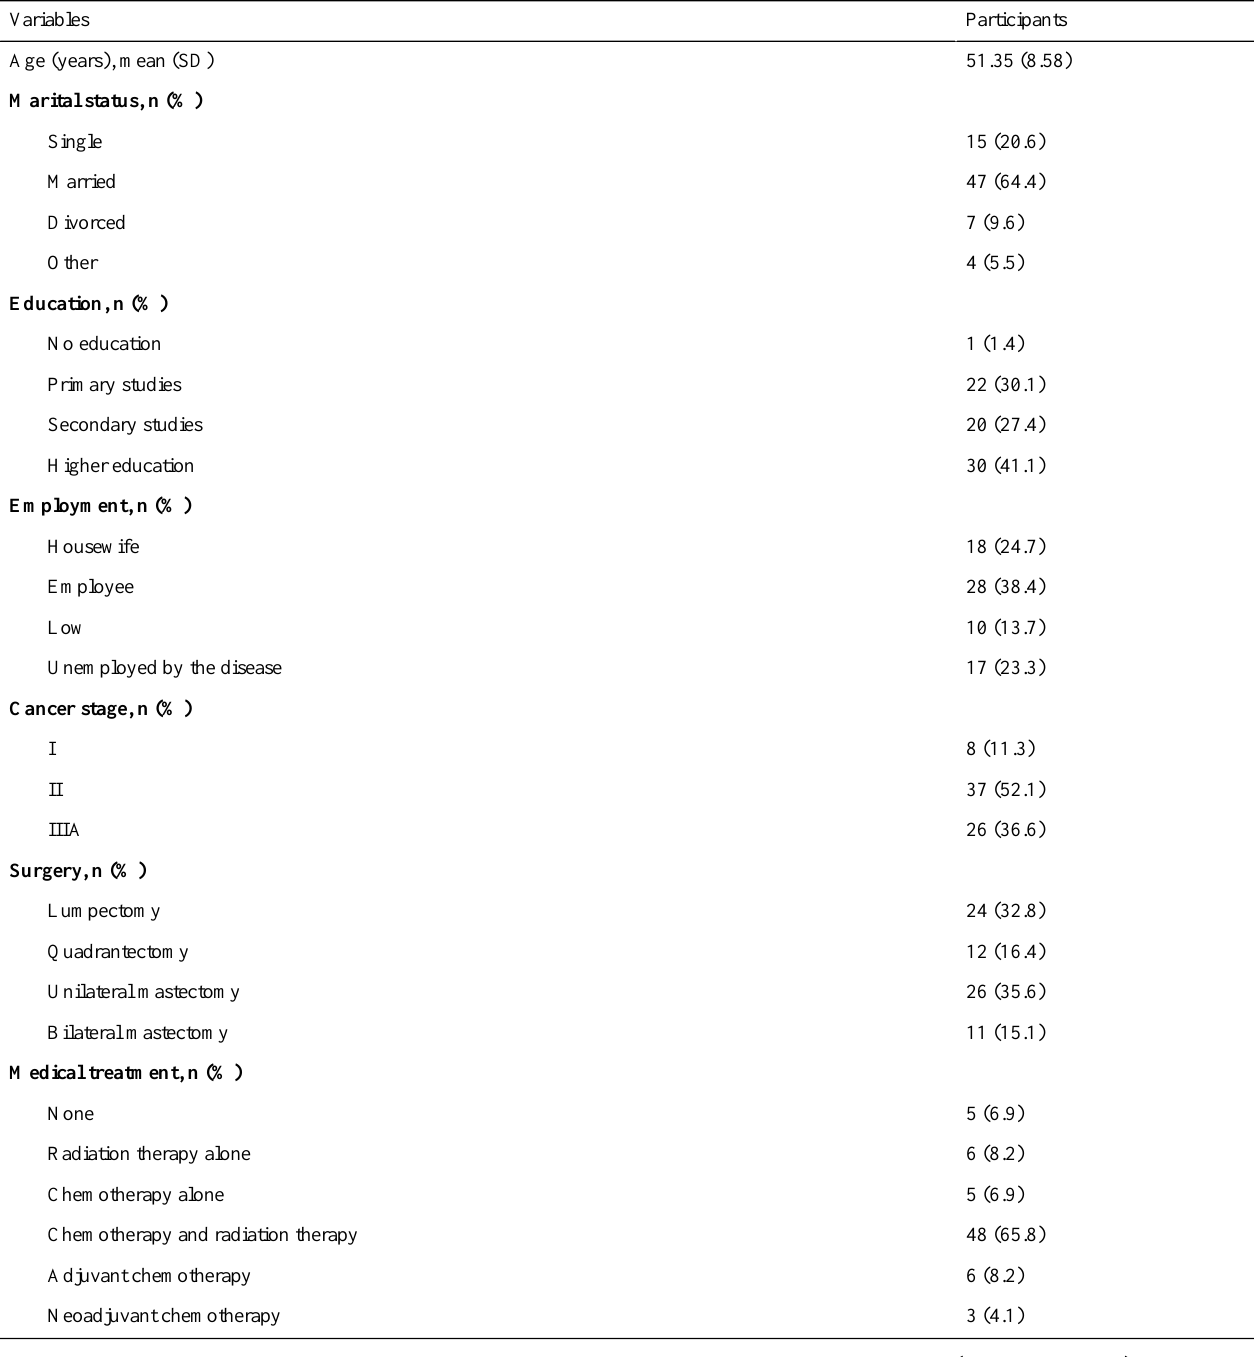
Table 1. Participants’demographics